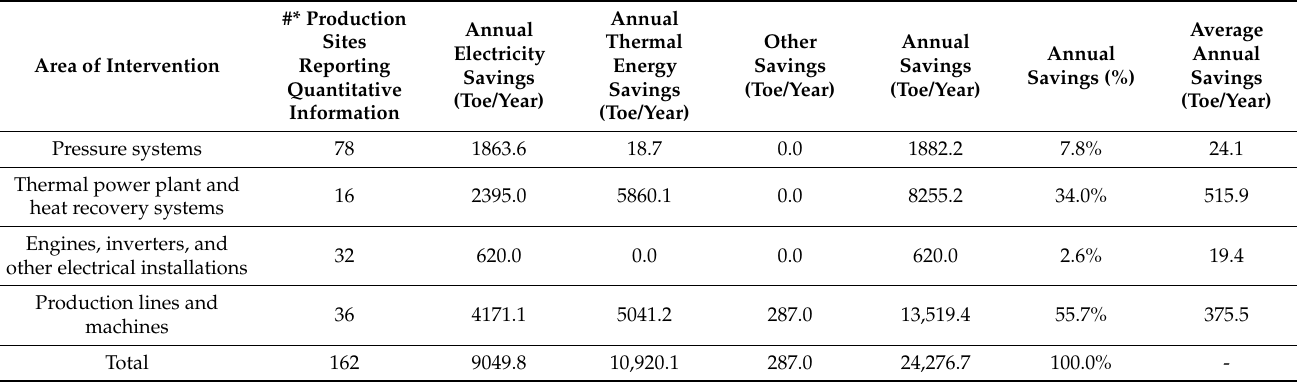
Table 7. Energy-savings assessed for the suggested technological interventions. The total annual savings are calculated as the sum of thermal energy, electricity, and fuel